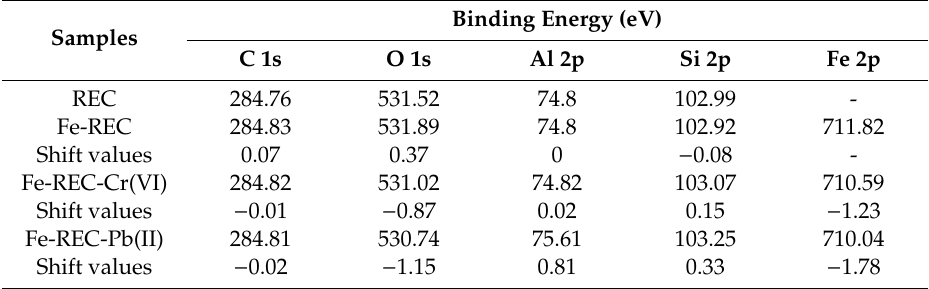
Table 3. Binding energy and its shift on the REC surface treated by modification and adsorption.